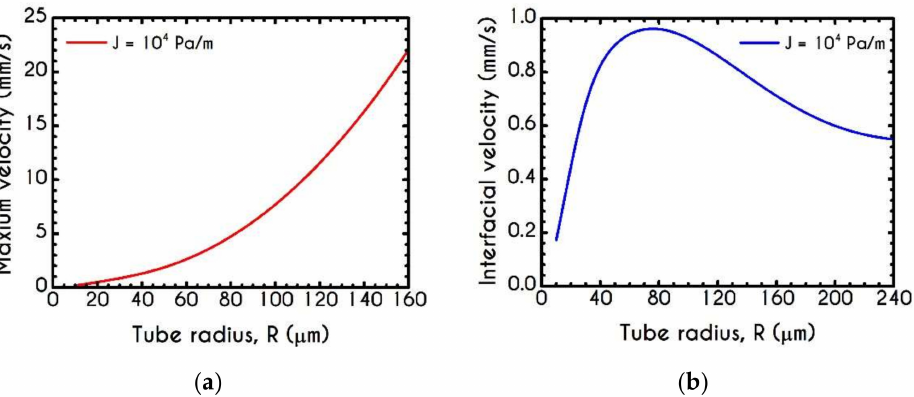
Figure 14. ( a ) Maximum axial velocity U max , and ( b ) Interfacial axial velocity U int as a function of tube radius R for J = 10 4 Pa/m and H c =